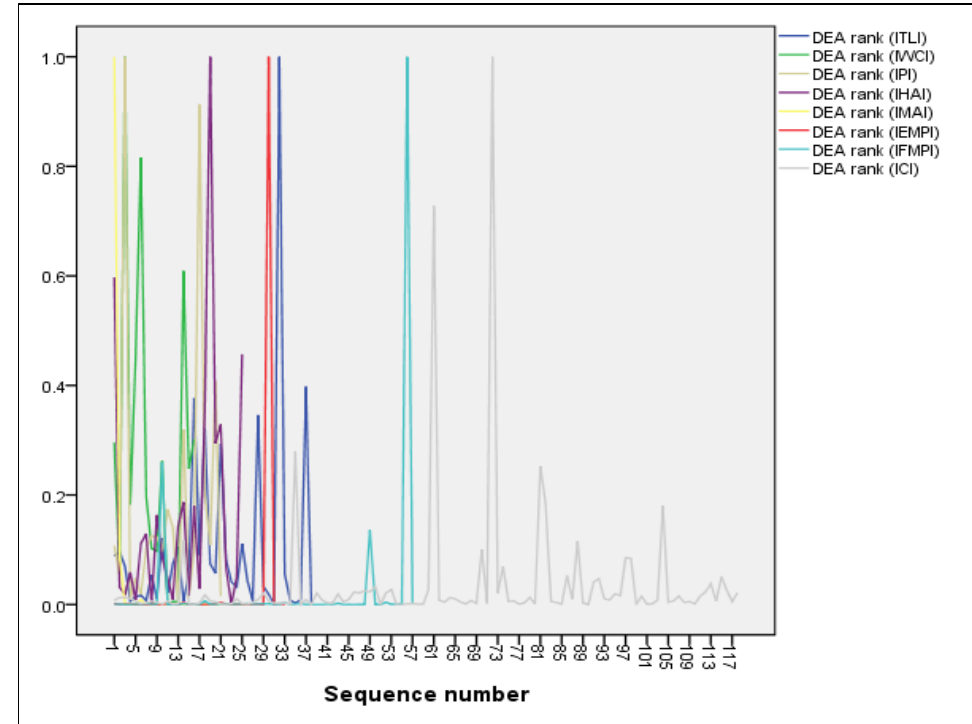
Figure 7: Sequence chart for values of ranks in DEA model.